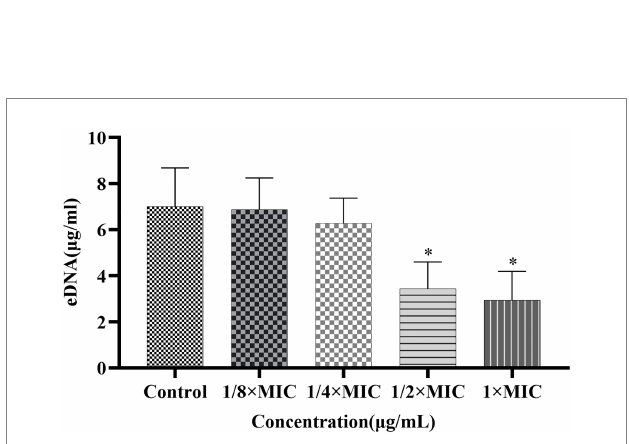
FIGURE 9 Effect of Disaspidin BB on the biofilm extracellular DNA of SEP-05. * means p < 0.05.